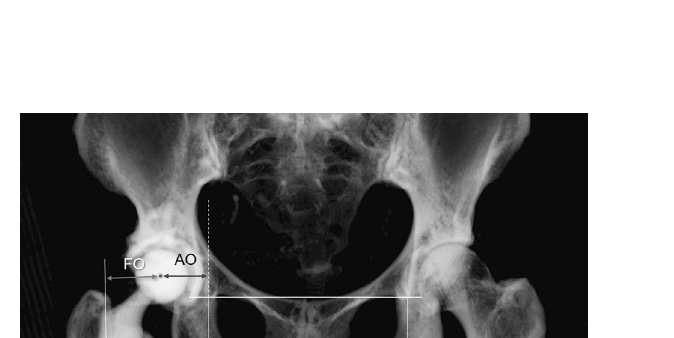
Table 1. Details of the participants. DDH developmental dysplasia of the hip, HOA hemilateral hip osteoarthritis. *Mean ± standard deviation (range).